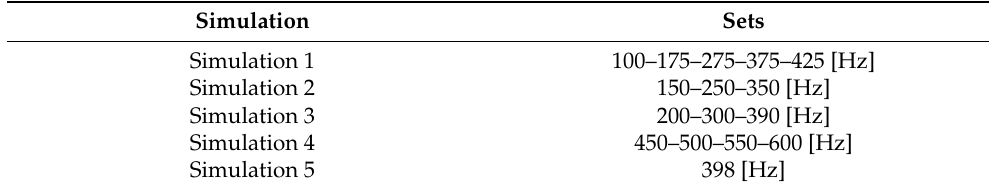
Table 3. Set of frequencies per simulation.